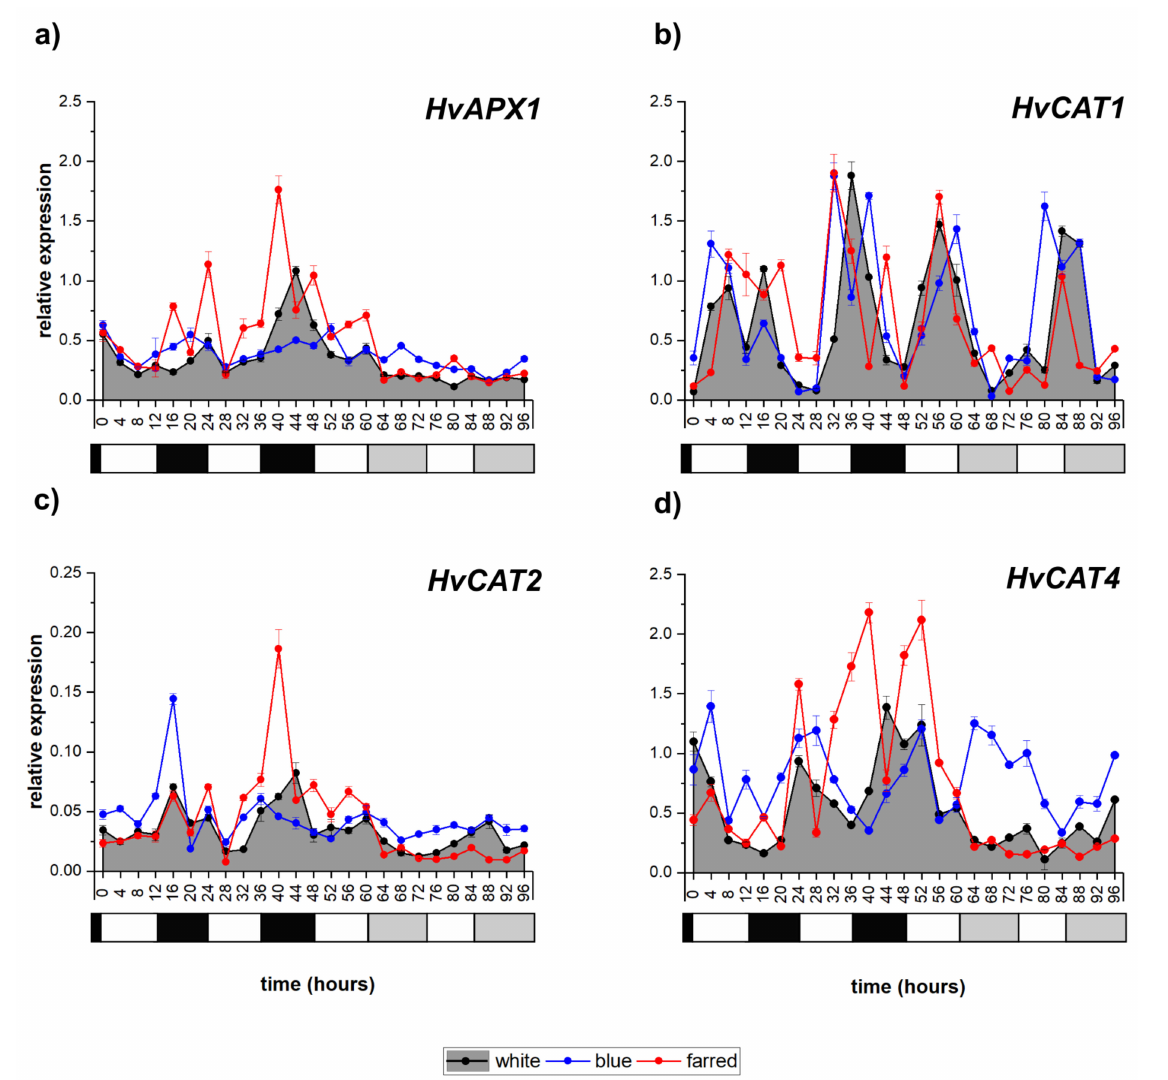
Figure 6. Expression patterns of H. vulgare antioxidant-enzyme-coding genes: ascorbate peroxidase 1 ( HvAPX1 ) ( a ) and catalase ( HvCAT1-4) ( b – d ), under white, blue and far-red light illumination, respectively. Calculating methods and the legends of graphs are the same as described in Figure 1. The following significant differences were calculated at p ≤ 5% level: HvAPX1— 0.049; HvCAT1— 0.17; HvCAT2— 0.013; HvCAT4—